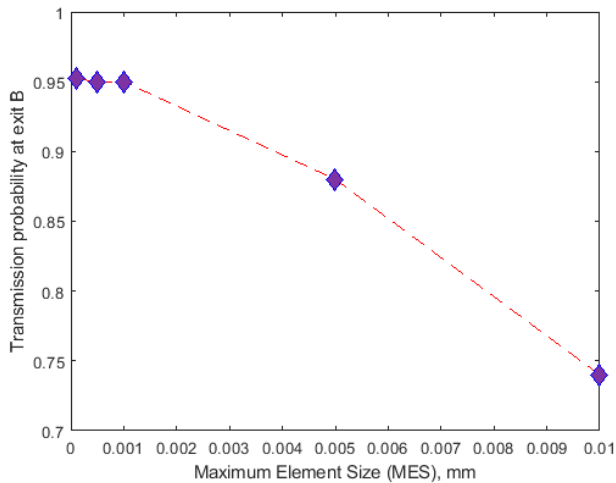
Figure 5. Transmission probability of ADCs as a function of the maximum element size at the separation zone, i.e., around the semicircular constriction region. Since MES at 0.001 mm, 0.0005 mm, and 0.0001 mm are almost similar, the simulation was completed fixing MES at 0.001 mm.